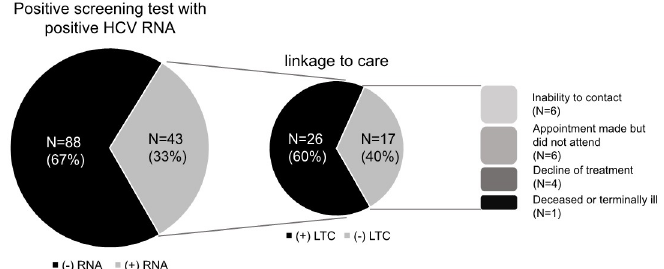
Fig 2. HCV screening and LTC with common